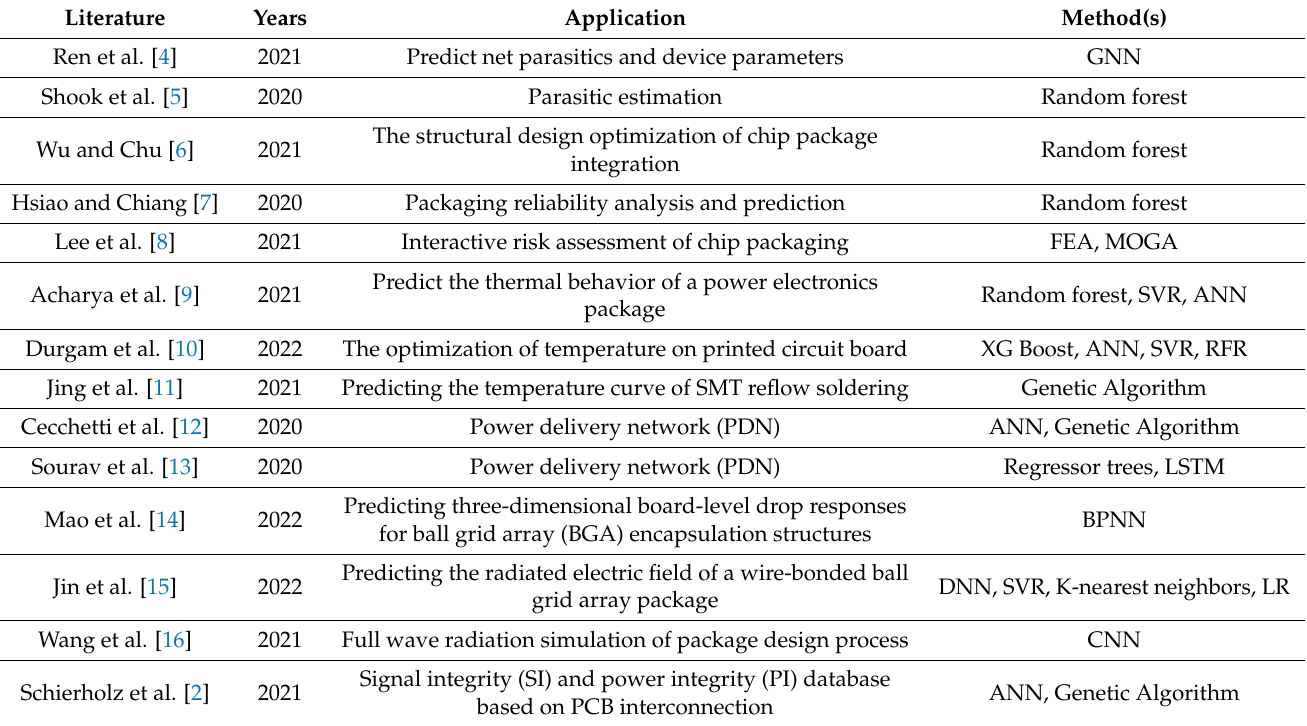
Table 1. Summary of ML-based IC packaging process